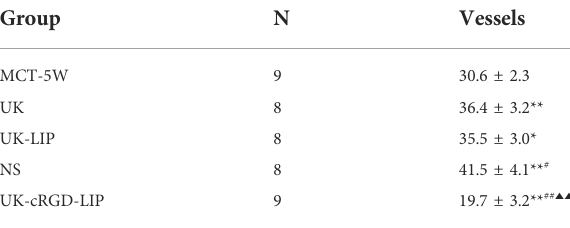
TABLE 1 The number of vessels with residual in-situ